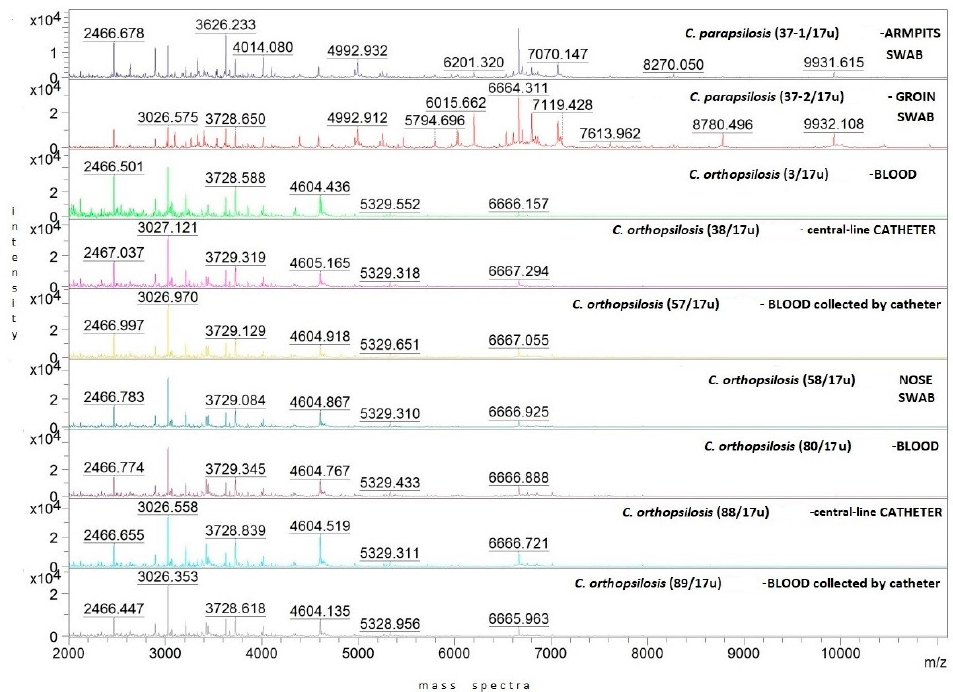
Figure 1. Representative MSPs for clinical C. parapsilosis and C. orthopsilosis strains isolated from different body locations of 59-year-old male patient with CBSI. Mass spectra intensity displayed in arbitrary units (a.u. = 0, 1, 2, 3, 4 × 10 4 ) on the y-axis, whereas mass-to-charge ratio expressed in m/z units on the x-axis; color was assigned to number of